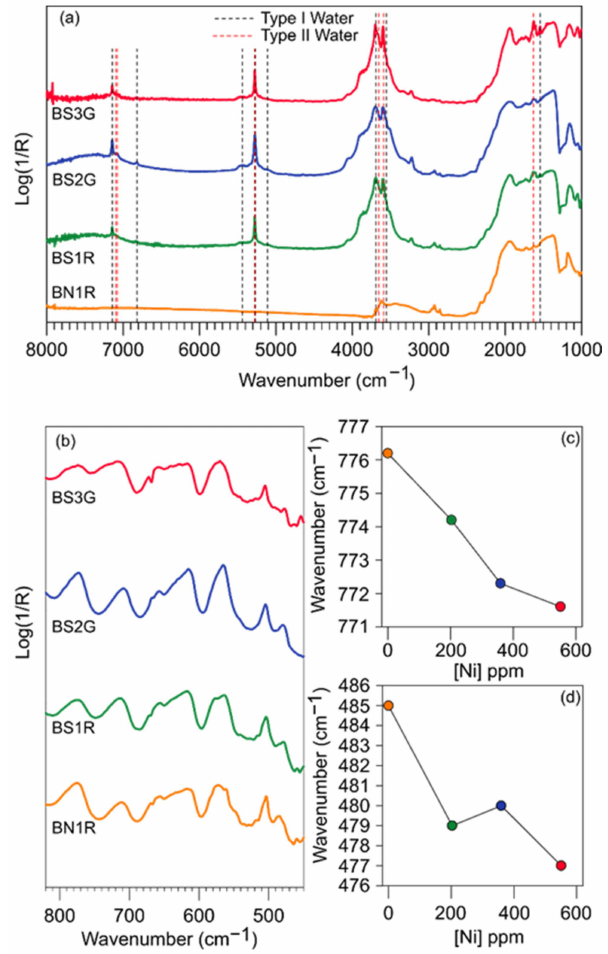
Figure 3. ( a , b ) Infrared spectra, in the 8000–400 cm − 1 range, of the three synthetic (BS1R, BS2G, and BS3G) and of the natural (BN1R) red beryl samples. Positions of the modes ascribable to the “type I” and “type II” H 2 O molecules are marked by dashed black (I) and red (II) lines, respectively. ( c , d ) Shift of the Al-O and Be-O stretching modes (at about 485 cm − 1 and 775 cm − 1 , respectively) as a function of the Ni content (see text for